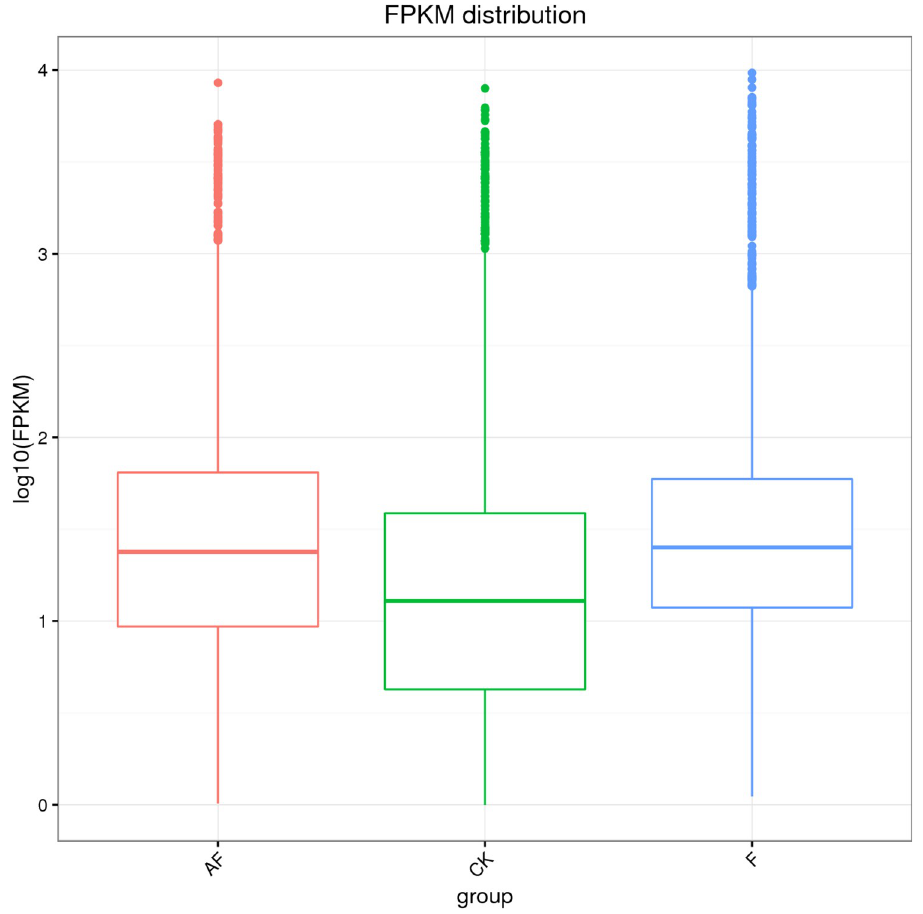
Fig 4. Box plot for comparing gene expression levels between groups. The vertical coordinate in the figure is the gene expression quantity, and each box represents a sample group. The line in the middle of the box represents the median, and the upper and lower sides of the box are the upper and lower quartiles respectively.